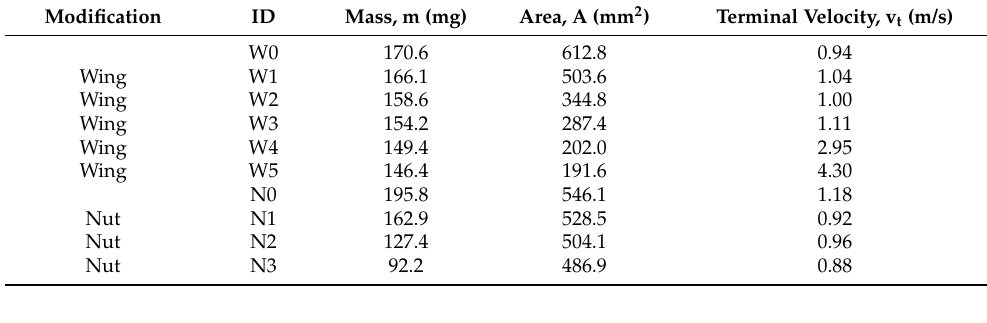
Table 1. Properties of falling seeds. Table lists mass and area of seeds in various states of modification of nut and wingplus the resulting terminal velocity. Reprinted/adapted with permission from Ref. [13]. © IOP Publishing Ltd. and London Mathematical Society 2011. Reproduced with permission. All rights reserved.